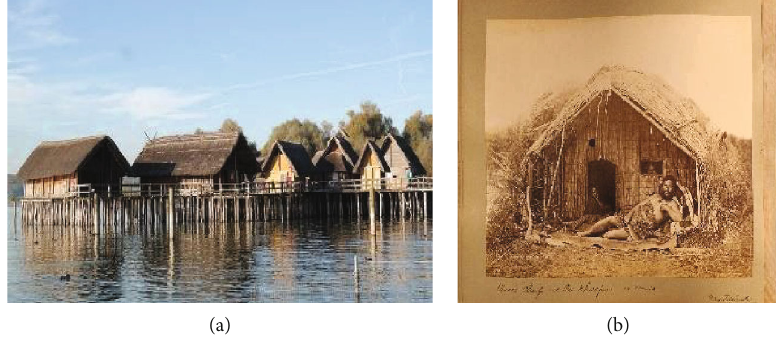
Figure 58: (a) Stilt houses: Asia; (b) Maori Reed House, New Zealand 1891 [35].